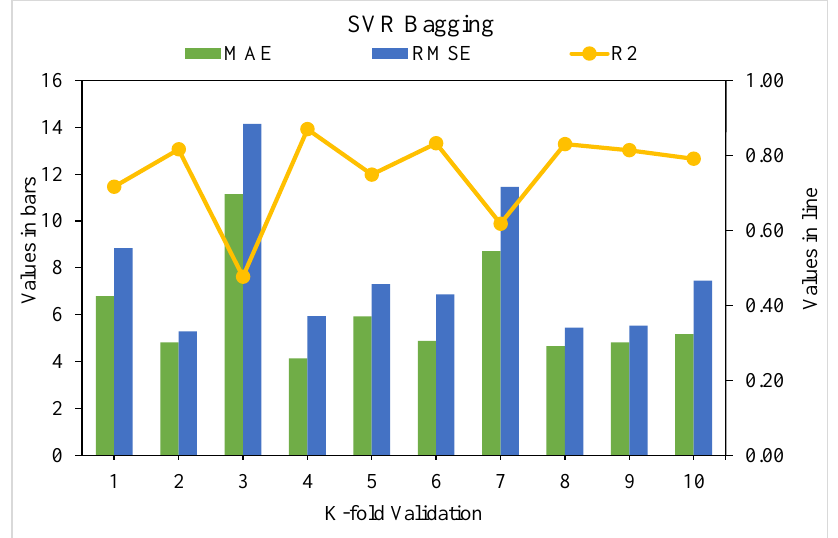
Figure 10. K-fold cross-validation representation for the AdaBoost model.